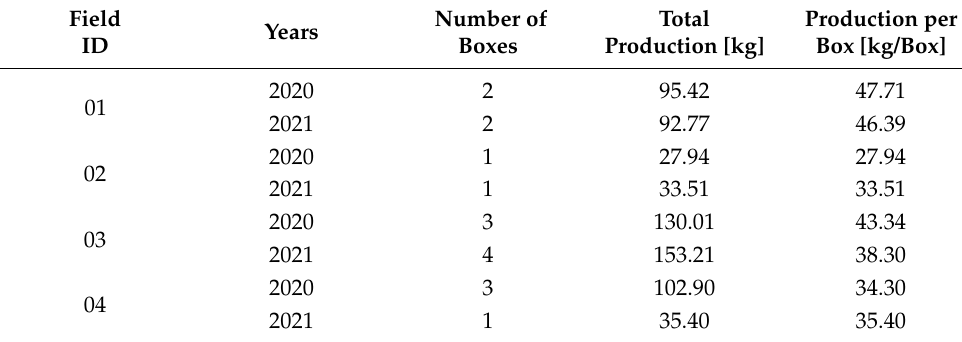
Table 3. Productive data per farm and per